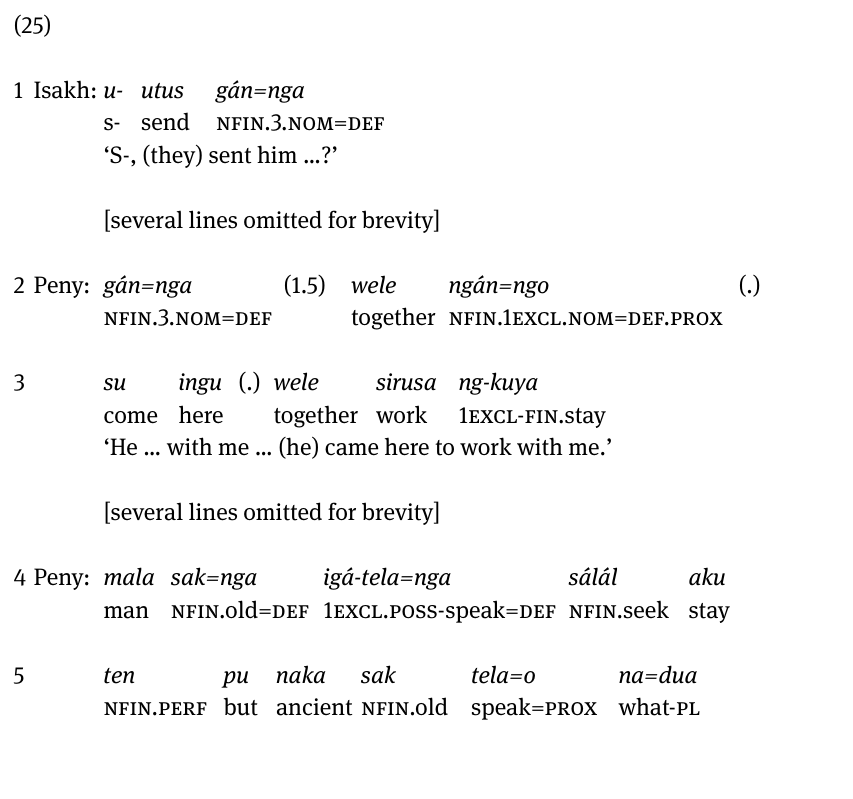
Figure 5. The apex of Matilda’s point In excerpt (25), Peny uses a prototypical S(mall)-point as part of an initial place reference formulation. In response to a query from Isakh (line 1), Peny is explaining the researcher’s arrival in the community and his purpose there. At line 6, Peny points twice, first aligned with the elevational numda ‘up there’, and second aligned with the word mana ‘village.’ Figures 6 and 7 show the apex of the two points (indicated in transcript line 6 as well). Both points involve use of the hand primarily, without full extension of the arm. While Peny’s gaze is aligned with the point, Isakh does not direct his own gaze in the direction of the point. Thus, Peny’s points here are both produced as and responded to as S(mall)-points in the sense of Enfield et al. (2007). Functionally, it seems that this may well be an ‘insecure reference environment’, as the place references comprises an initial reference that is subsequently expanded upon using a place name, suggesting that the initial formulation may not have been adequate (see also Section